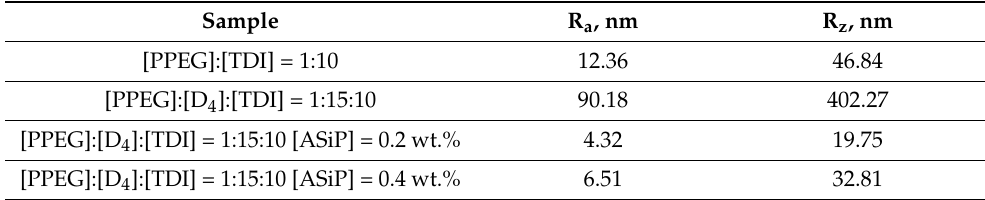
Table 1. Arithmetic average roughness height (Ra) and a mean roughness depth (Rz) for samples.